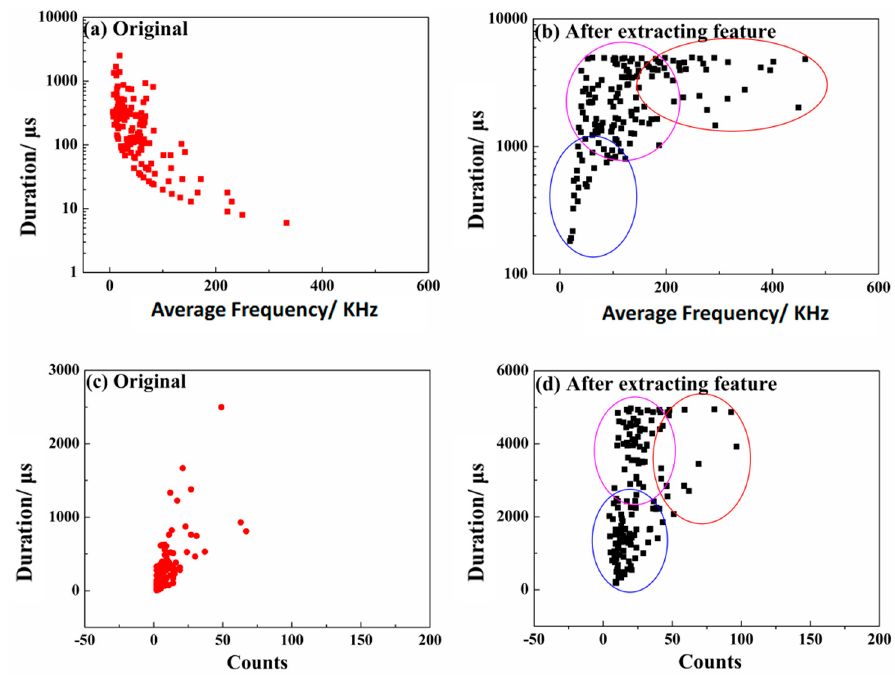
Figure 9. Analysis of the parameters of the signals of Q235 carbon steel in 2000 mg/L NaHCO 3 + 1000 mg/L NaCl: ( a ) and ( c ) original relationship of the duration-average frequency and duration-counts, ( b ) and ( d ) the relationship of duration-average frequency and duration-counts after the extracting feature.